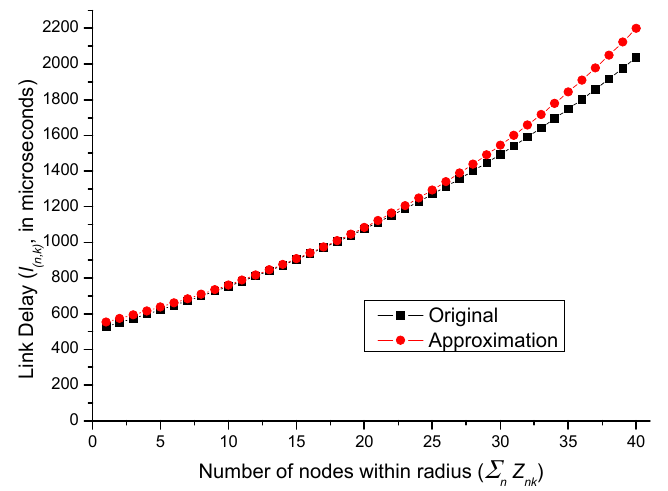
Figure 3. Link delay approximation function versus the original